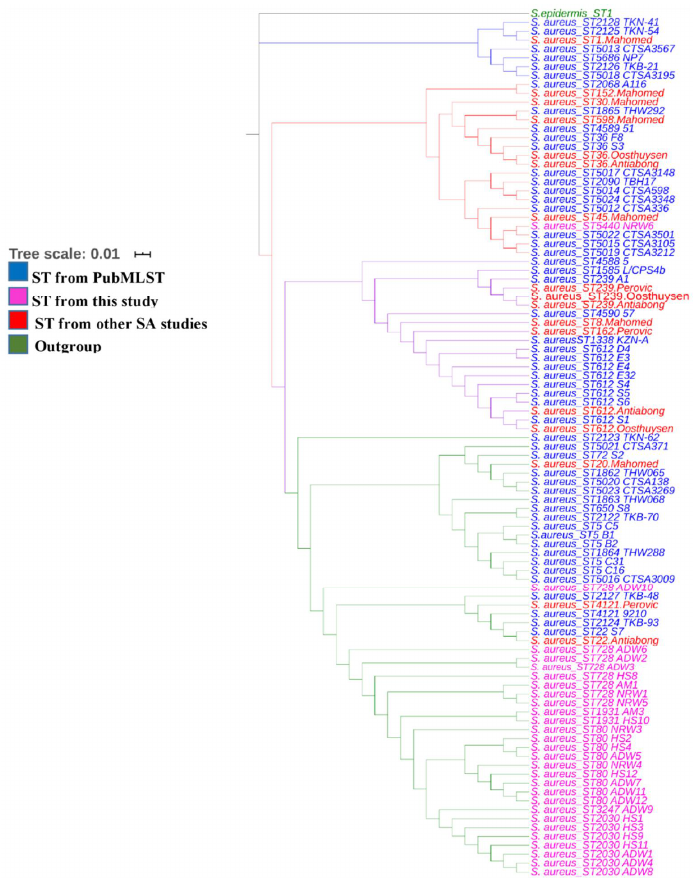
Figure 4. The phylogenetic tree of S. aureus isolates generated involving our isolates and those from other South African studies using iTol v.3.The isolates from the PubMLST database are coloured blue, ST for this study are pink, other South African studies are red, and the outgroup is in green.